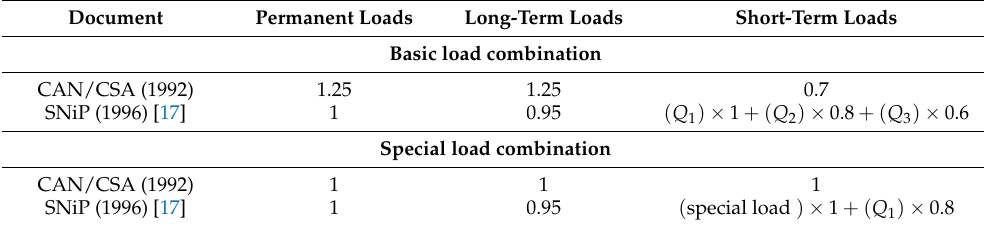
Table 8. Examples of load combination factors for I class reliability of structures